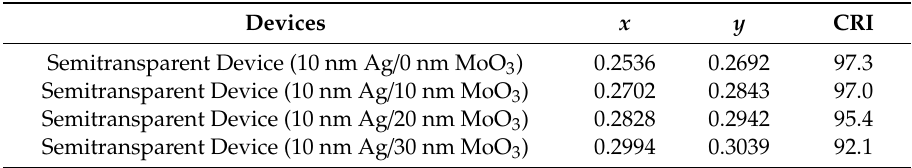
Figure 5. Representation of the colour coordinates ( x, y ) of all devices using a standard D65 illumination light source on the CIE 1931 colour space. Table 3. Colour rendering index (CRI) and corresponding colour coordinates ( x , y ) of different semi-transparent devices.